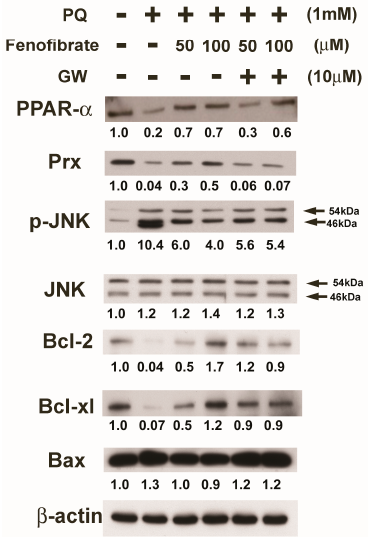
Figure 6. Effects of fenofibrate on the expression of paraquat (PQ)-induced apoptosis and stress-signaling pathway-related proteins assessed by western blot analysis. RF/6A cells were pretreated with a high or low dose of fenofibrate for 1 h, then exposed to 1 mM PQ for 1 h (for phospho-c-Jun amino-terminal kinase (p-JNK)) or 24 h. In GW6471 (GW) treated groups, the cells were incubated with 10 μ M GW6471 for 1 h before fenofibrate treatment. The expression levels of peroxisome proliferator-activated receptor type α (PPAR- α ), peroxiredoxin (Prx), p-JNK, JNK, B-cell lymphoma 2 (Bcl-2), Bcl-xl, and B-cell lymphoma 2-associated X protein (Bax) are shown and the fold changes compared to those in control group are presented under the protein bands. β -actin was used as an internal control.